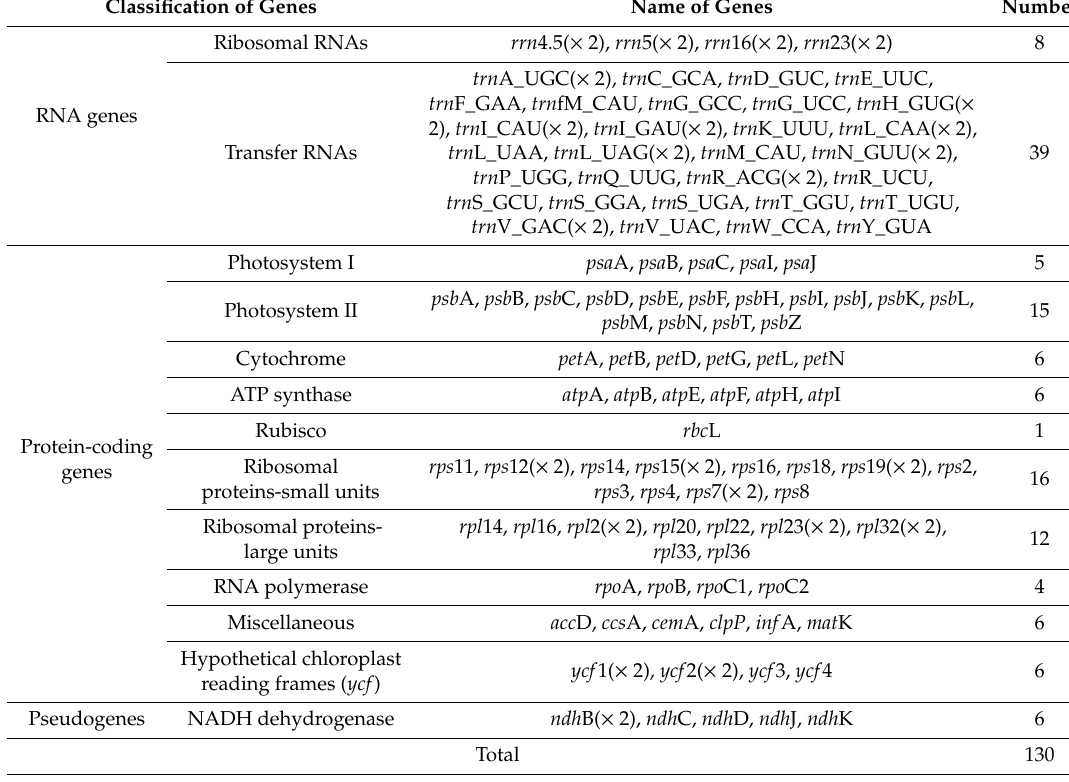
Table 1. List of annotated genes in the Paphiopedilum delenatii chloroplast genome.